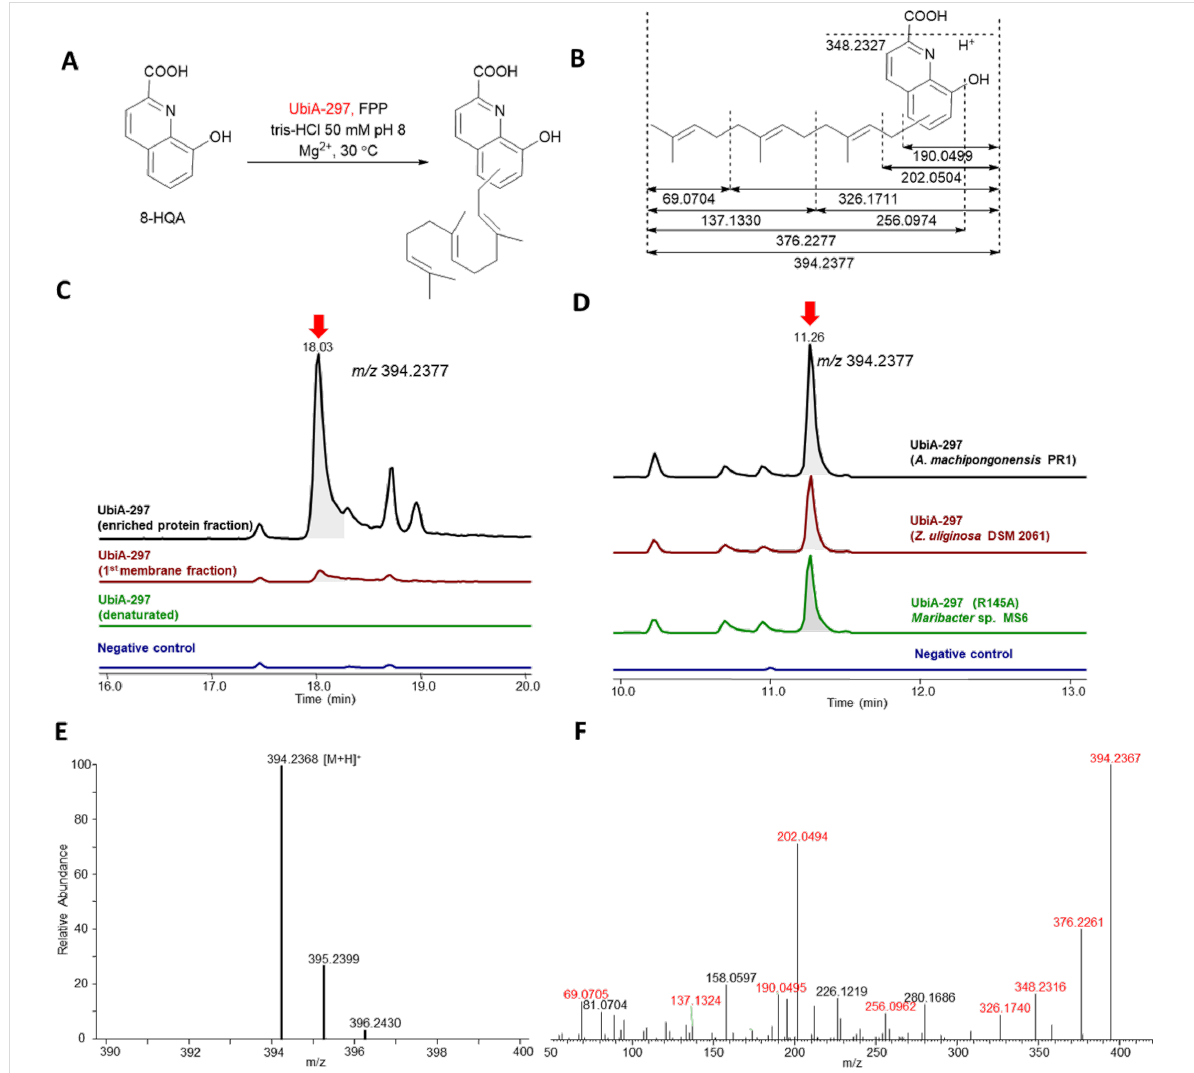
Figure 6: A) Reaction scheme of UbiA-297 catalyzing the assumed para -directed farnesylation of 8-HQA; B) calculated MS 2 fragmentation pattern of farnesylated 8-HQA; C) extracted ion chromatogram (EIC) for m / z 394.2376 ( t R 18.03 min, red arrow) of enriched UbiA-297 protein fractions, cell- membrane fraction containing UbiA-297 ( Maribacter sp. MS6), denaturated enriched UbiA-297 (negative control), and enriched E. coli BL21 derived membrane fractions (negative control not shown); fixed ion intensity scale (5.00E7) was applied to all chromatograms; D) EIC for m / z 394.2376 ( t R 11.26 min) of assay containing membrane-bound UbiA-297 encoded in A. machipongonensis sp. PR1, Z. uliginosa DSM 2061, and point mutated UbiA-297 (R145A) from Maribacter sp. MS6; E and F) HRMS and MS 2 spectrum showing fragmentation of prenylated 8-HQA ( m / z 394.2367, t R 18.03